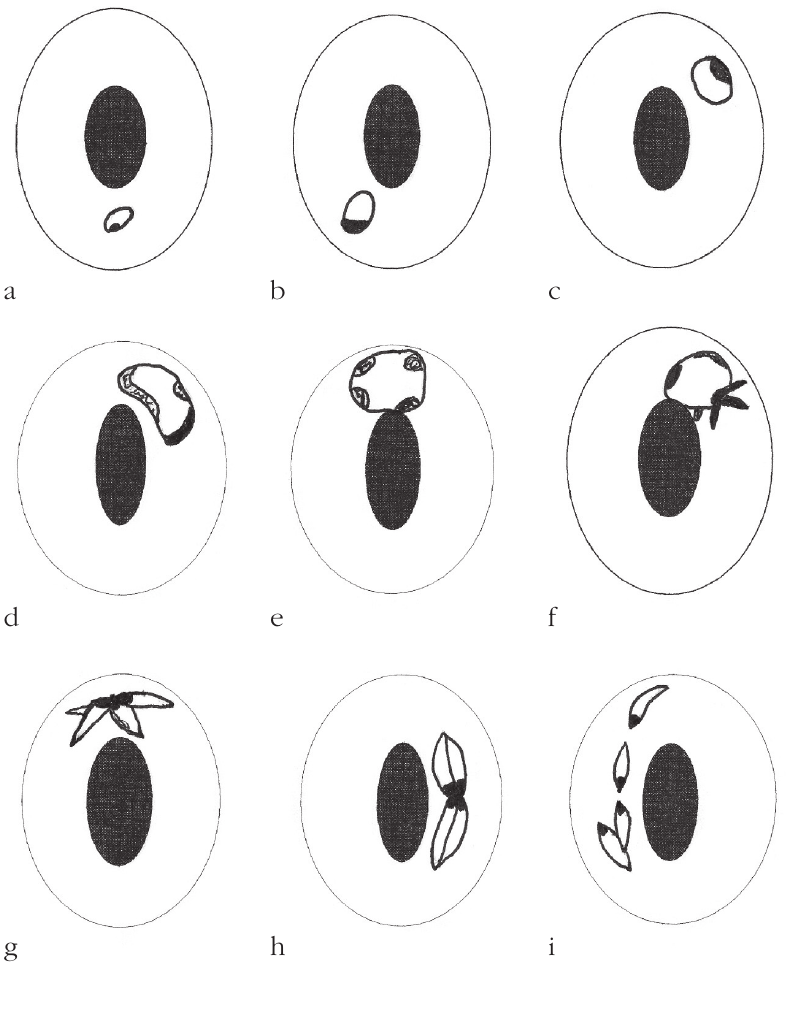
Fig. 2. – Drawings illustrating the deve- lopment of Babesia ugwidiensis sp. nov. in Phalacrocorax carbo . (a) early ring form; (b-c) trophozoites; (d) elongate schizont precursor; (e) spherical schizont precursor showing four chro- matin masses; (f) developing amoeboid schizont; (g-h) mature tetrad schizonts; (i) merozoites separated from schizont. Scale bar = 4 μ